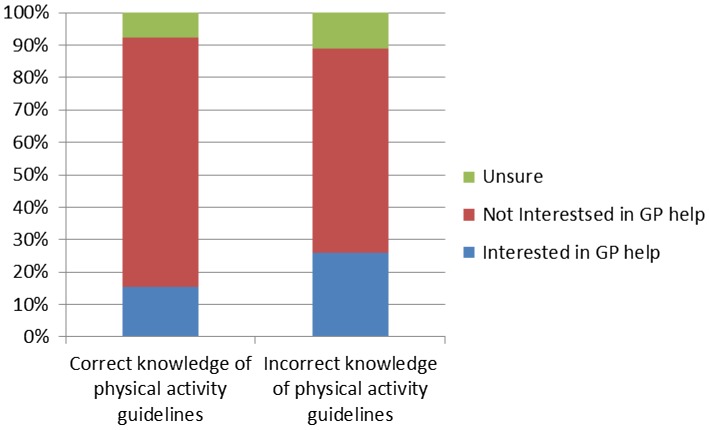
Percentage of patients who correctly knew the national guidelines and were interested in GP help in physical activity.